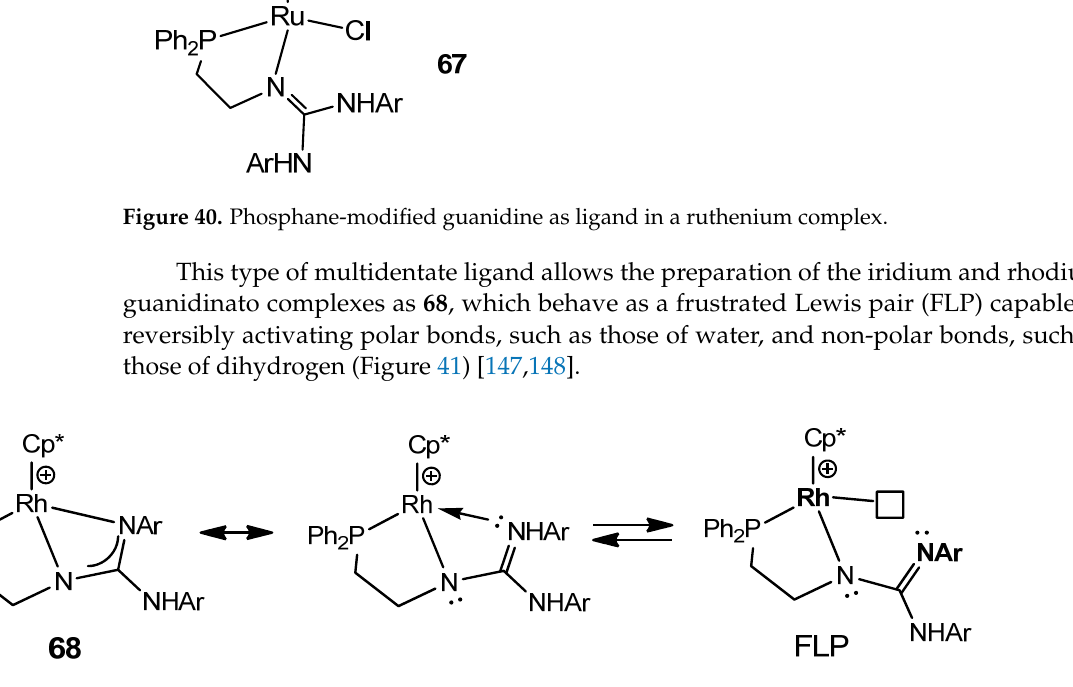
Figure 41. Frustrated Lewis pair based in rhodium phosphanoguanidinato complexes.